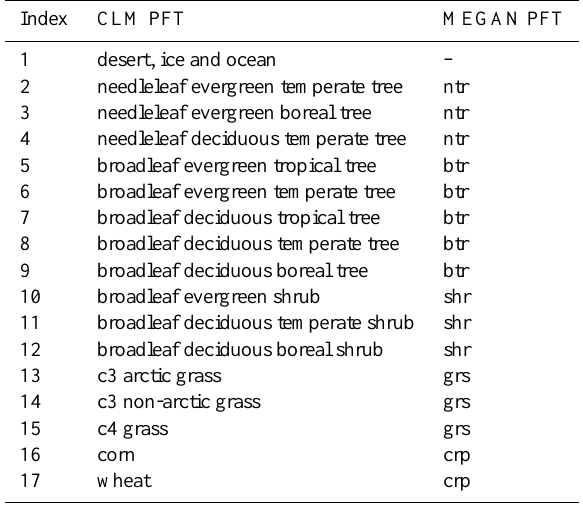
Table 8. Plant functional types in Community Land Model (CLM) landcover files and corresponding MEGAN